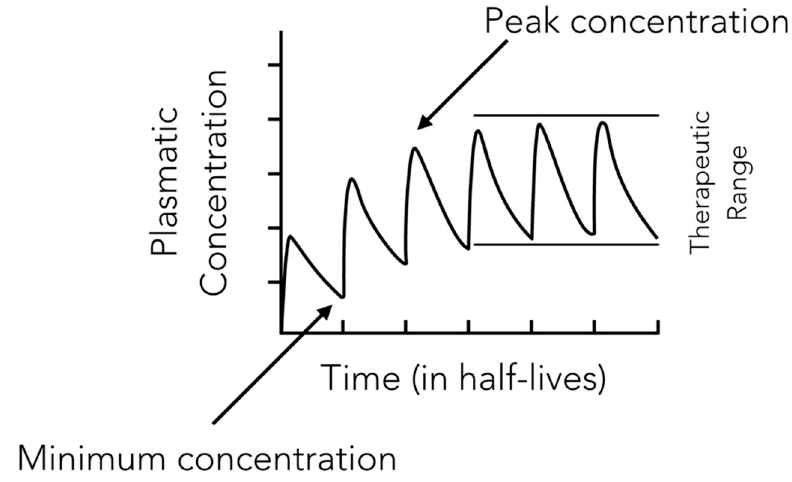
Figure 3. Figure showing how the therapeutic range is contained between the minimum and the peak concentration.